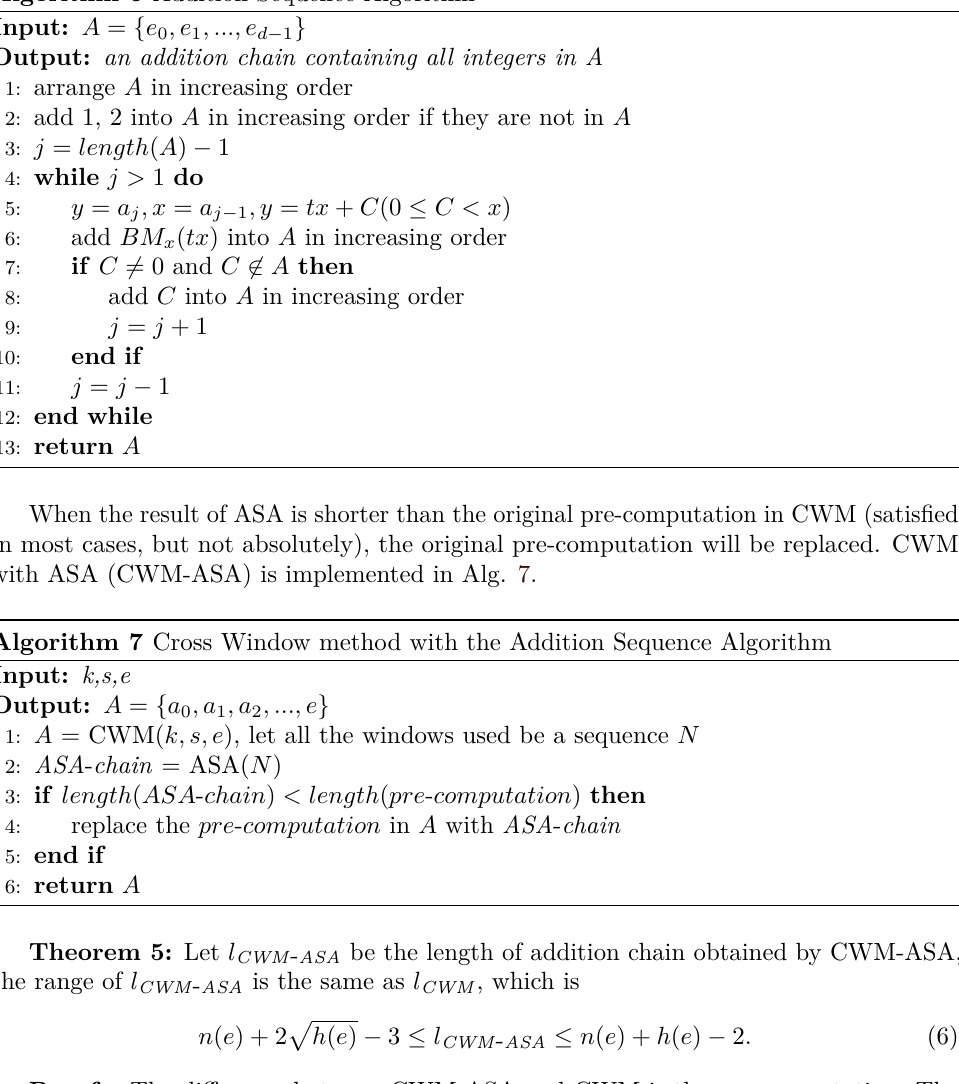
Algorithm 6 Addition Sequence Algorithm